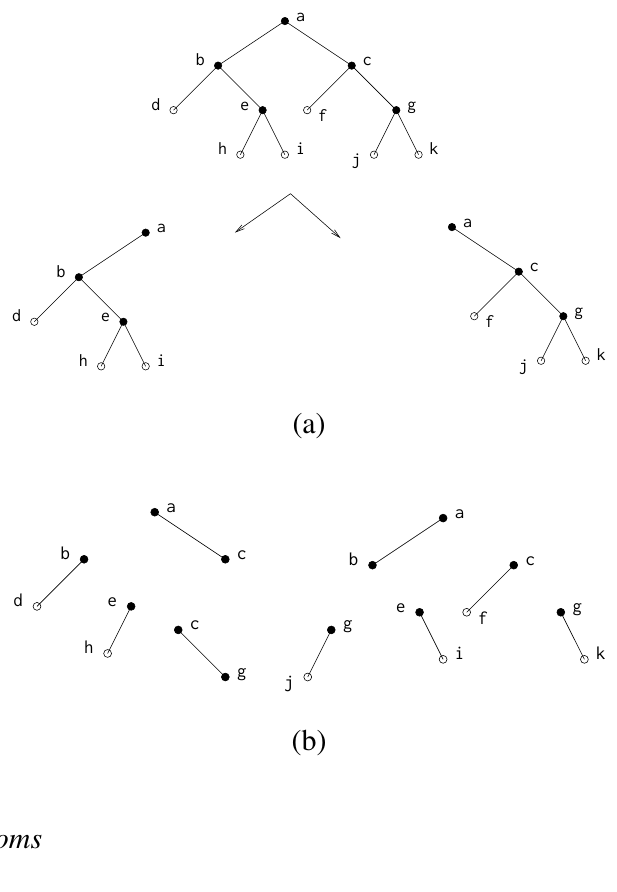
Figure 6. (a) A decomposition step using minimal separator { a } . The minimal separators (except for { a } ) are partitioned into the two subtrees obtained. (b) Total